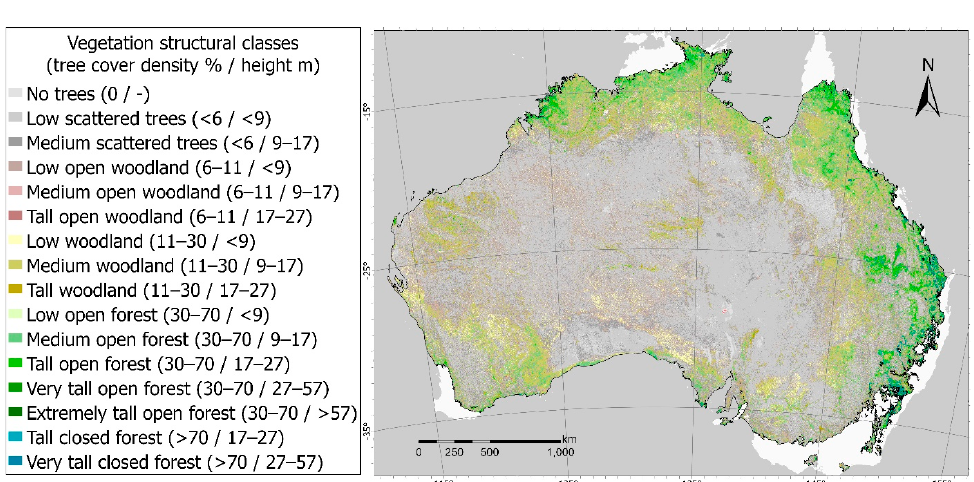
Figure 2. Vegetation structure classified according to tree density and height. Modified from Scarth et al. [55] .